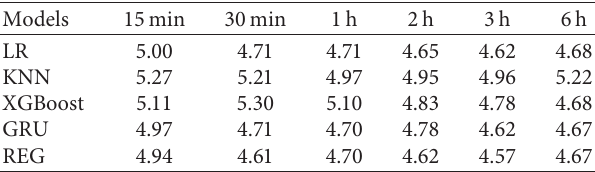
Table 1: Multimodel MAE comparison table for different step sizes.